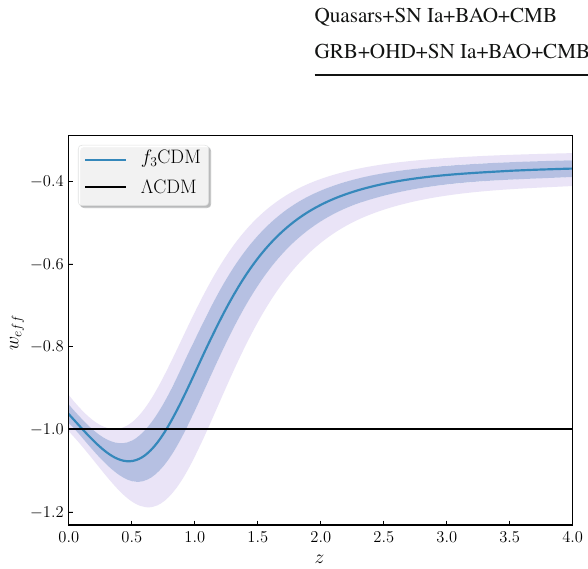
Table 4 Summary of the best-fit values of parameters for the f 3 CDM model with 1 σ uncertainties for different observations